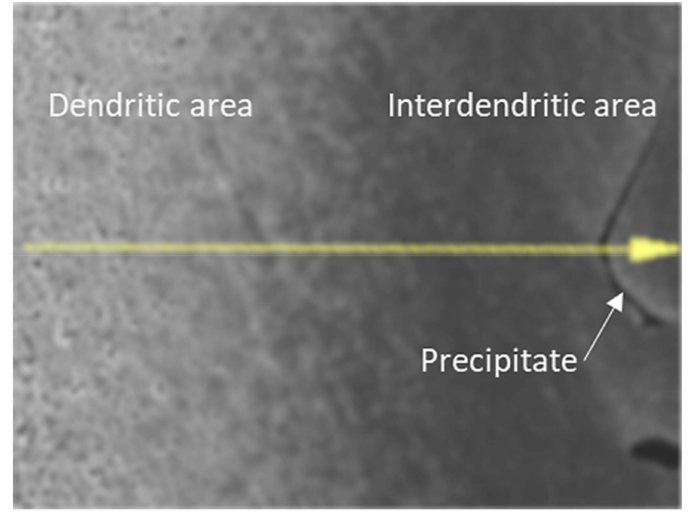
Figure 15. Example of an EDX line analysis from dendritic area to the interdendritic